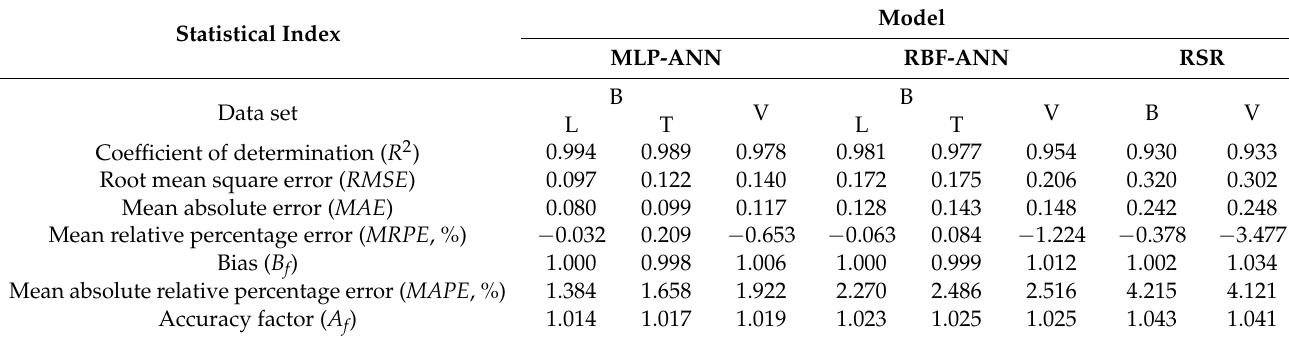
Table 3. Values of indicators used to evaluate performance of ANN and RSR models to predict the content of phytosterols in a stored bulk of rapeseed calculated for all data sets: L—learning, T—test B—building (L + T) and